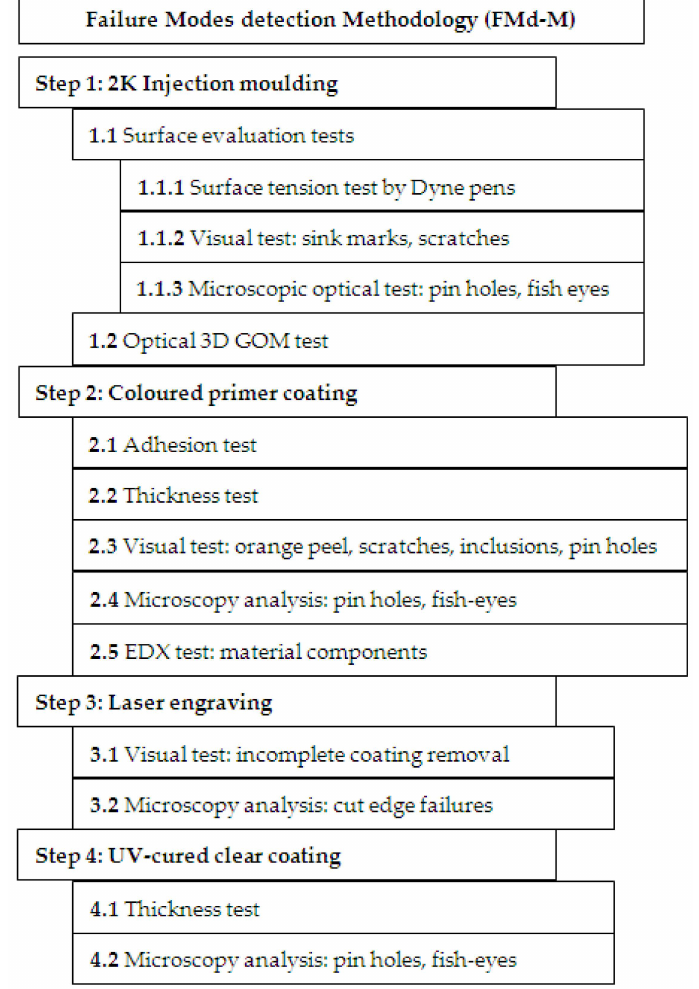
Figure 1. Novel Failure Modes detection methodology.